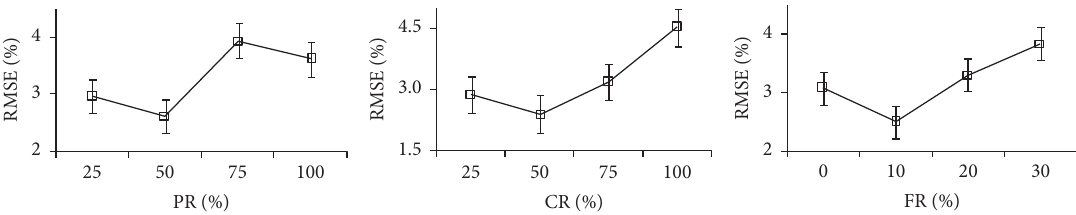
Figure 7: Influence of PR, CR, and FR on RMSE of calibration model.